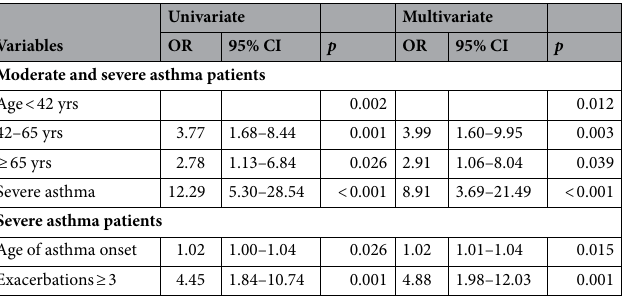
Table 4. Univariate and multivariate regression analysis of appearance of bronchiectasis in the study population. OR: odds ratio. CI: confidence interval. The multivariate model is the final model after stepwise removal of covariates.